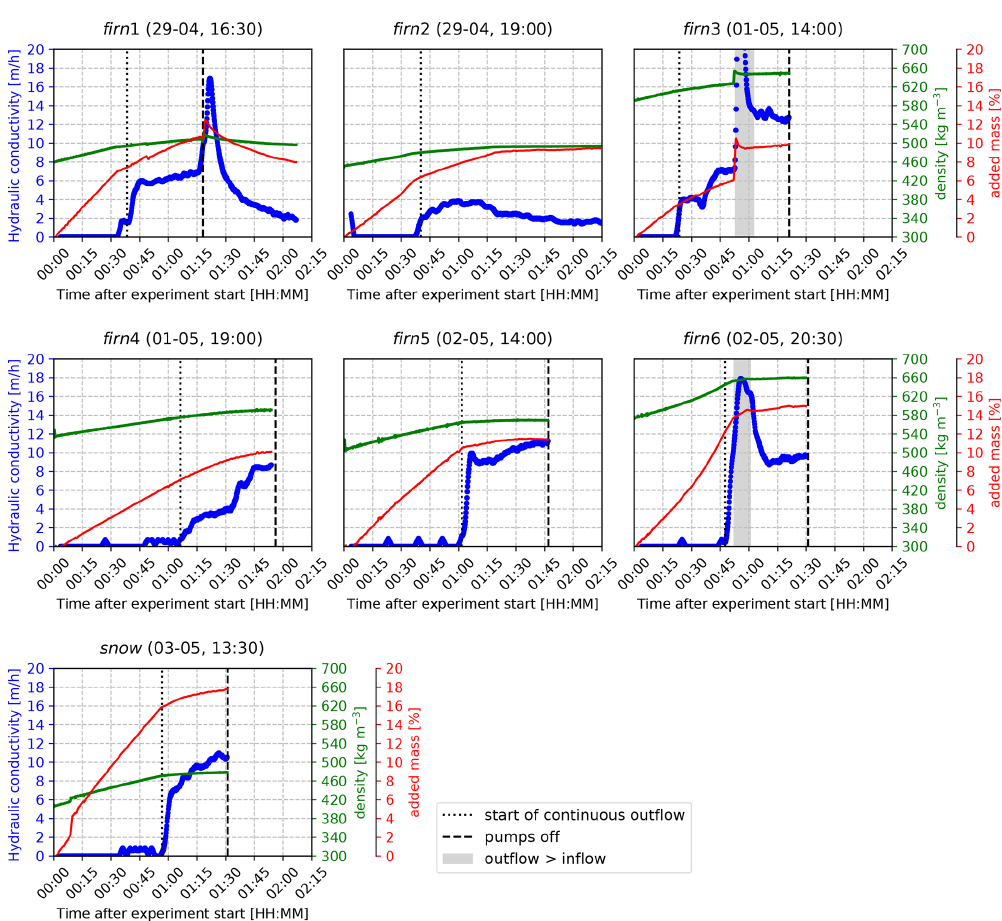
Figure 5. Hydraulic conductivity, added mass and density over time for seven individual ROSA experiments. In blue is the calculated hydraulic conductivity, in red is the firn sample mass as a percentage of its mass pre-experiment, and in green is the density over time. The dotted line indicates start time of continuous outflow, and the dashed line shows the time at which water supply was stopped (note that for experiment firn2 the label “pumps off” is not shown since this experiment was continued for longer than the time displayed here). Grey shading shows where outflow > inflow. The title shows the name of the experiment and its starting date and time (dd-mm, HH:MM) in local time (UTC − 4:00); all measurements were carried out in 2021.